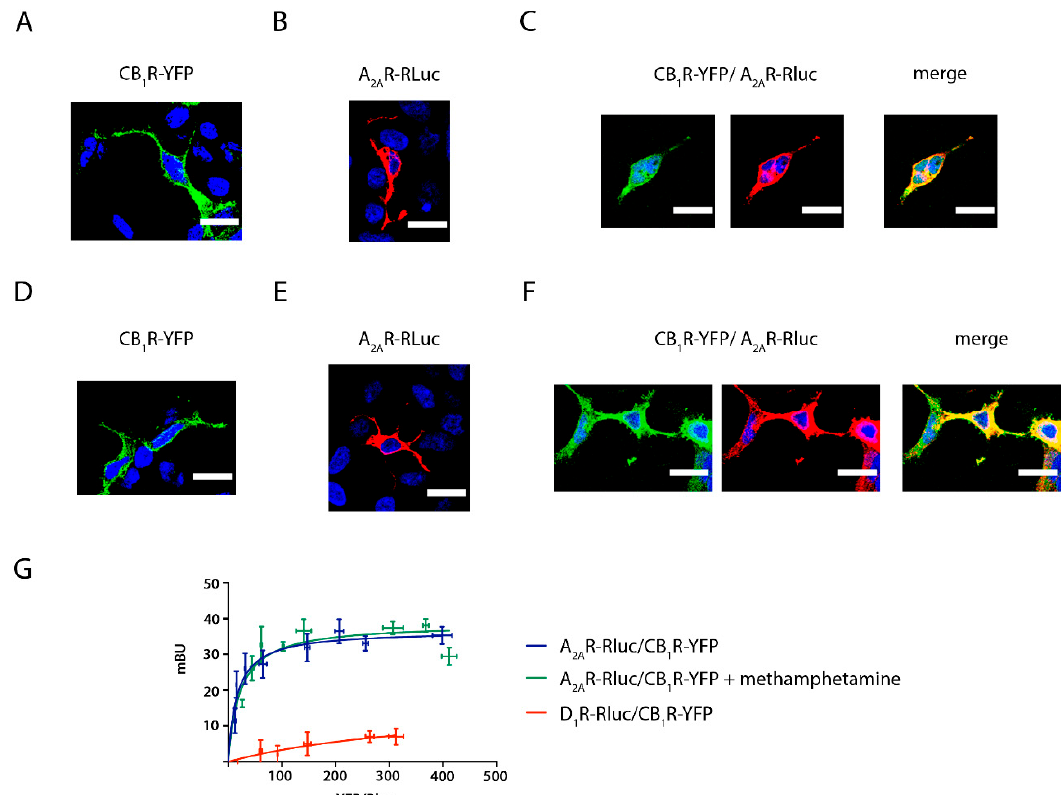
Figure 1. The effect of methamphetamine on A 2A R–CB 1 R colocalization and receptor–receptor interaction. Confocal microscopy images were obtained in HEK-293T cells transfected with 0.5 µ g cDNA coding for CB 1 R-YFP ( A , D ), with 0.5 µ g cDNA for A 2A R-Rluc ( B , E ) or with 0.5 µ g cDNA for both CB 1 R-YFP and A 2A R-Rluc ( C , F ). Cells were treated with 1 µ M methamphetamine ( D – F ) or vehicle ( A – C ) for 1 h. Receptors fused to Rluc (red) were identified by immunocytochemistry and receptors fused to YFP (green) were identified by their own fluorescence. Colocalization is shown in yellow. Nuclei were stained with Hoechst (blue). Images are taken near the surface of the slide to observe a higher portion of the plasma membrane. Scale bars: 20 µ m. ( G ): Bioluminescence Resonance Energy Transfer (BRET) assays were performed in HEK-293T cells transfected with a constant amount of the cDNA coding for A 2A R fused to Rluc (1 µ g) or the cDNA coding for D 1 R fused to Rluc (0.5 µ g to 4.5 µ g) (red line) and increasing amounts of the cDNA coding for CB 1 R fused to YFP (0.5 µ g to 4.5 µ g). Transfected cells were treated (green dots) or not (blue dots) with 1 µ M methamphetamine. BRET is expressed as milli BRET units (mBU) and is given as the mean ± SEM of 8 different experiments grouped by amount of BRET acceptor.